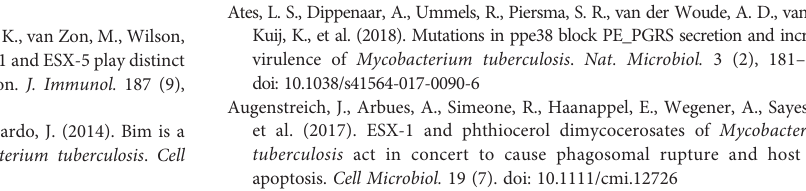
Supplementary Figure 1 | Construction of the ppe31 Mm mutant. Schematic representation of the strategy used for the generation of ppe31 Mm gene replacement mutant (A) . Con fi rmation of ppe31 Mm disruption in mutant. PCR ampli fi cations were performed using speci fi c primers. The result shows the PCR ampli fi cation gives a product of 2.2kb for wildtype M. marinum and 1kb for D ppe31 Mm (B) . Supplementary Figure 2 | PPE31 signi fi cantly increased the expression of in fl ammatory cytokines via reactive oxygen species in BMDMs. BMDMs were infected with WT, D ppe31 Mm or comp- D ppe31 Mm in the presence or absence in DPI (10 m M). After 6h, the level of in fl ammatory cytokines was assessed by RT- qPCR for expressions of TNF- a and IL-6. WT, wild-type M. marinum , * p < 0.05, ** p < 0.01. Data are shown as mean±S.E.M. of three independent experiments. * p < 0.05, ** p < 0.01. Supplementary Figure 3 | PPE31 signi fi cantly increased the expression of in fl ammatory cytokines through JNK-dependent signaling. BMDMs were pretreated with U0126 (5, 10, 20 mM), SB203580 (SB; 1, 5, 10 mM), or SP600125 (SP; 5, 10, 20 mM) for 1h, and then infected with D ppe31 Mm for1h, washed three times by PBS. After 6h, the level of in fl ammatory cytokines was assessed by real time PCR for expressions of TNF- a and IL-6. Supplementary Figure 4 | Generation of ppe31 Mtb gene replacement mutant. (A) Generation of M. tuberculosis ppe31 Mtb gene replacement mutant. Schematic representation of the strategy used for the generation of ppe31 Mtb gene replacement mutant. (B) Con fi rmation of ppe31 Mtb disruption in mutant. PCR ampli fi cations were performedusingspeci fi cprimers,usinggenomicDNAofH37Rvand D ppe31 Mtb mutant. TheresultshowsthePCRampli fi cationwithRvppe31-LLandRvppe31-RRpair,which gives a product of 3.2kb for H37Rv and 5.6kb for D ppe31 . Supplementary Figure 5 | RAW264.7 cells were infected with H37Rv or D ppe31Mtb(MOIs=10)for 6h.Thelevelexpressionsofin fl ammatorycytokines,TNF (A) and IL-6 (B) were assessed by RT-qPCR. The sensitivity of M. tuberculosis strains to acidcondition.Thebacteriagrowntomid-logphasewerecollectedbycentrifugationand resuspended to the OD600 of 0.5 in 5 ml 7H9 (pH = 4.5 or 5.5). The results are percent survivalposttreatmentwith7H9medium(pH=4.5or5.5) for7d (C)